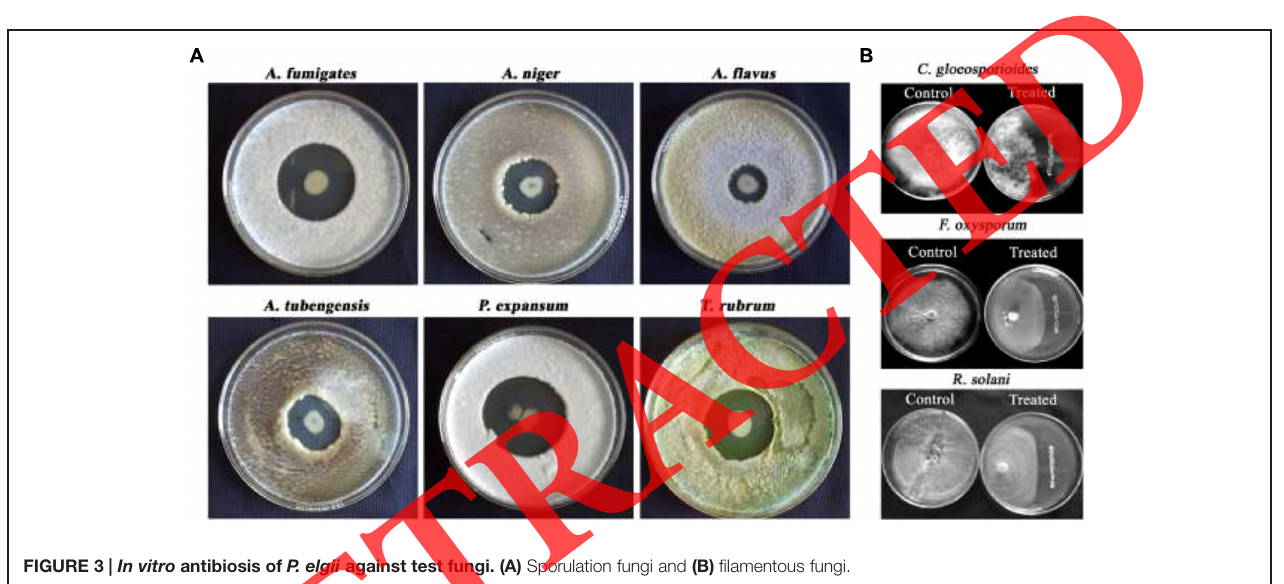
FIGURE 3 | In vitro antibiosis of P. elgii against test fungi. (A) Sporulation fungi and (B) filamentous